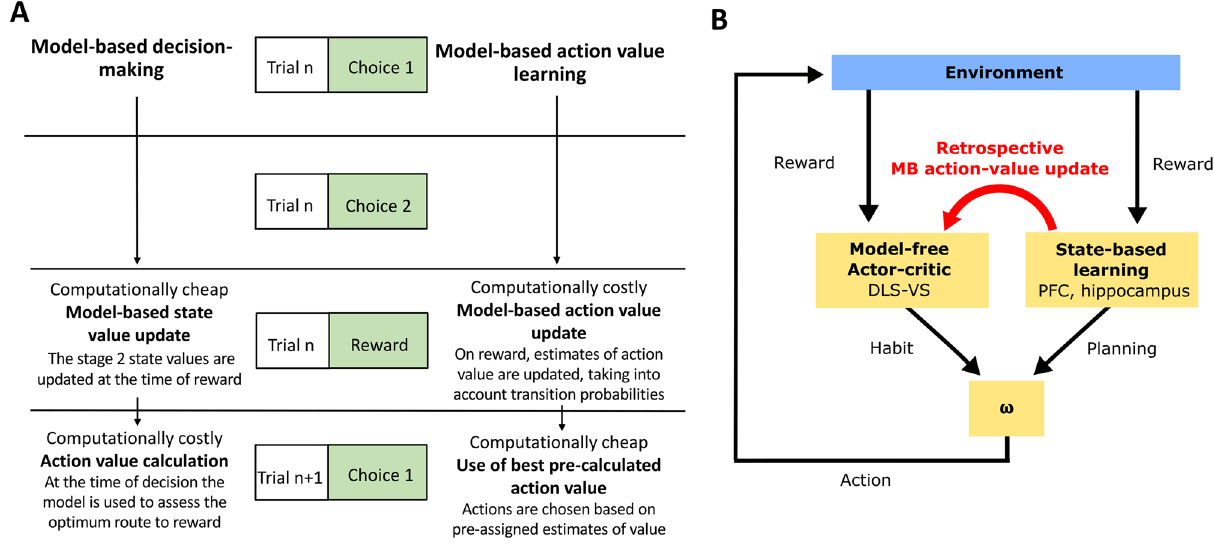
Figure 6. Schematic figures ( A ) Timecourse comparison of traditional model-based decision-making and model-based action value learning. Traditional model-based decision-making involves prospectively assessing action value at the time of decision, whereas model-based action value learning retrospectively assigns value at the time of reward, meaning on decision the action value estimates are already available. ( B ) Schematic of traditional actor-critic architecture for model-free learning with additional model-based transfer marked with red arrows. ω arbitration between model-free and model-based system, RPE reward prediction error, VS ventral striatum, DLS dorsolateral striatum, PFC prefrontal